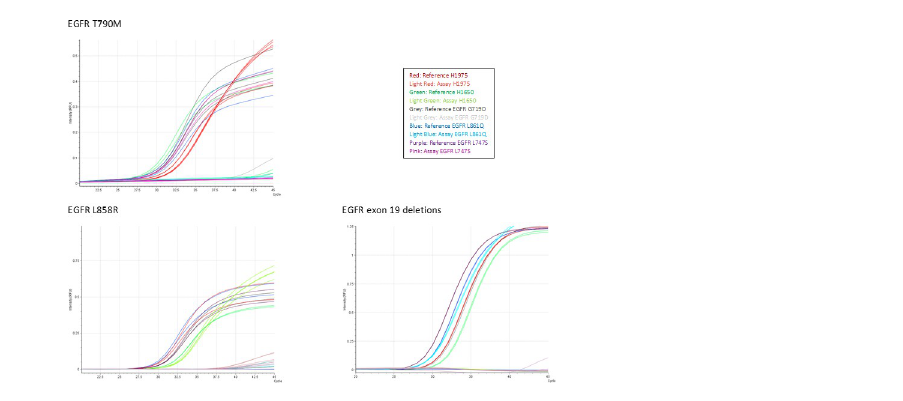
PLOS ONE | https://doi.org/10.1371/journal.pone.0253687 June 24,